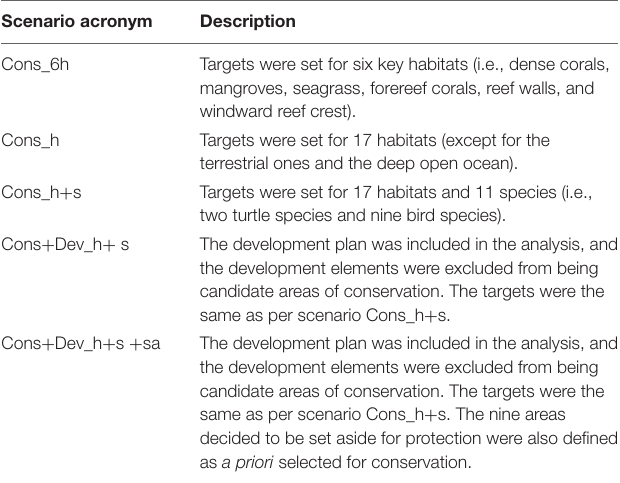
TABLE 2 | Description of the five different scenarios created in the context of the study. Scenario